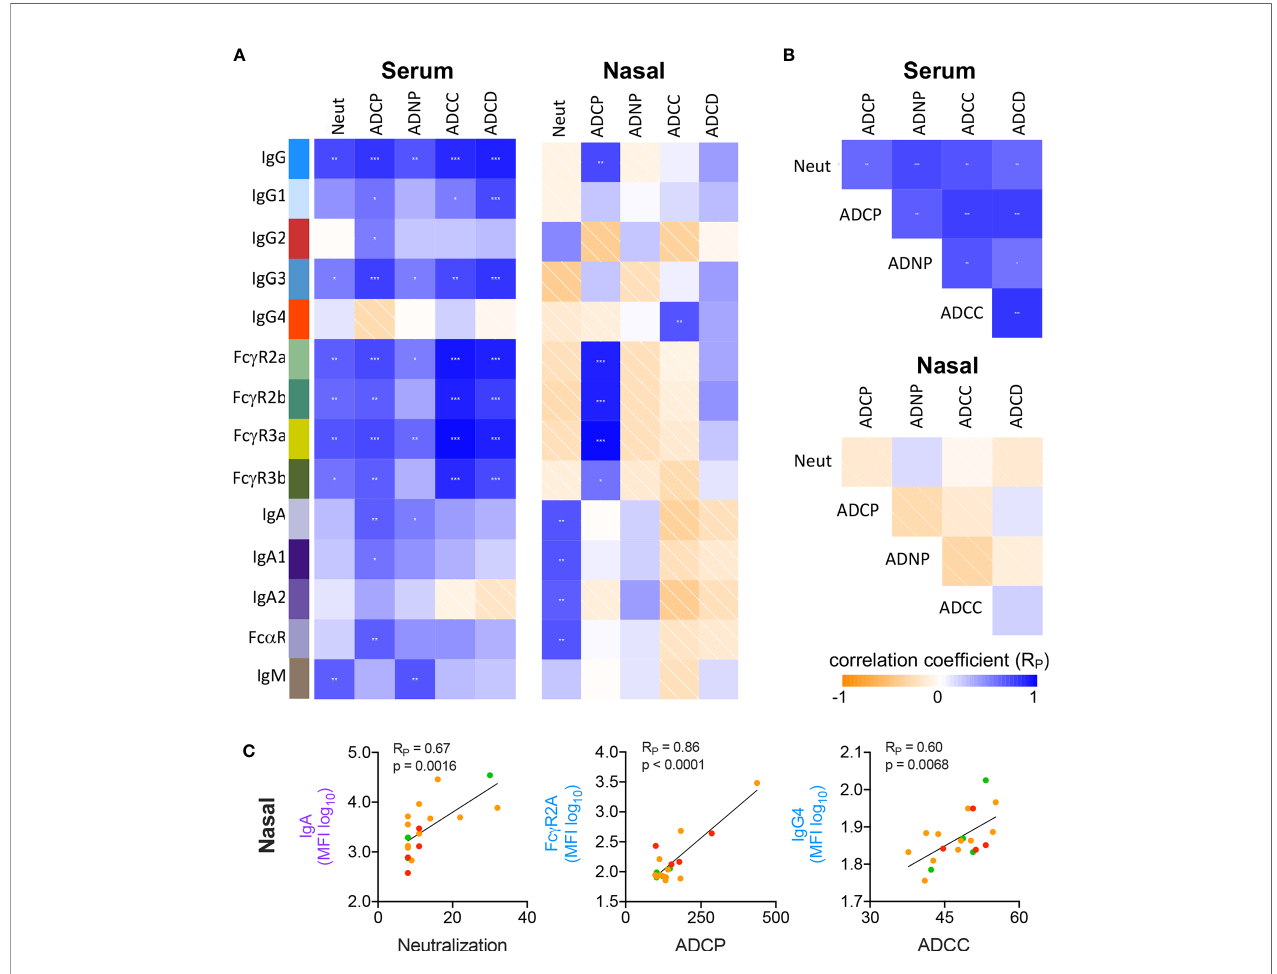
FIGURE 3 | Correlative relationships between RBD-speci fi c Ab features and functions. (A) Correlations observed between RBD-speci fi c Ab features and functions in serum (left) and nasal wash (right) samples. (B) Correlations observed between Ab functions observed in serum (top) and nasal wash (bottom). (C) Representative scatterplots between highly correlated Ab features and functions in nasal wash samples. p values from unpaired two tailed t-tests with Welch ’ s correction. Pearson correlation coef fi cients (R P ) are